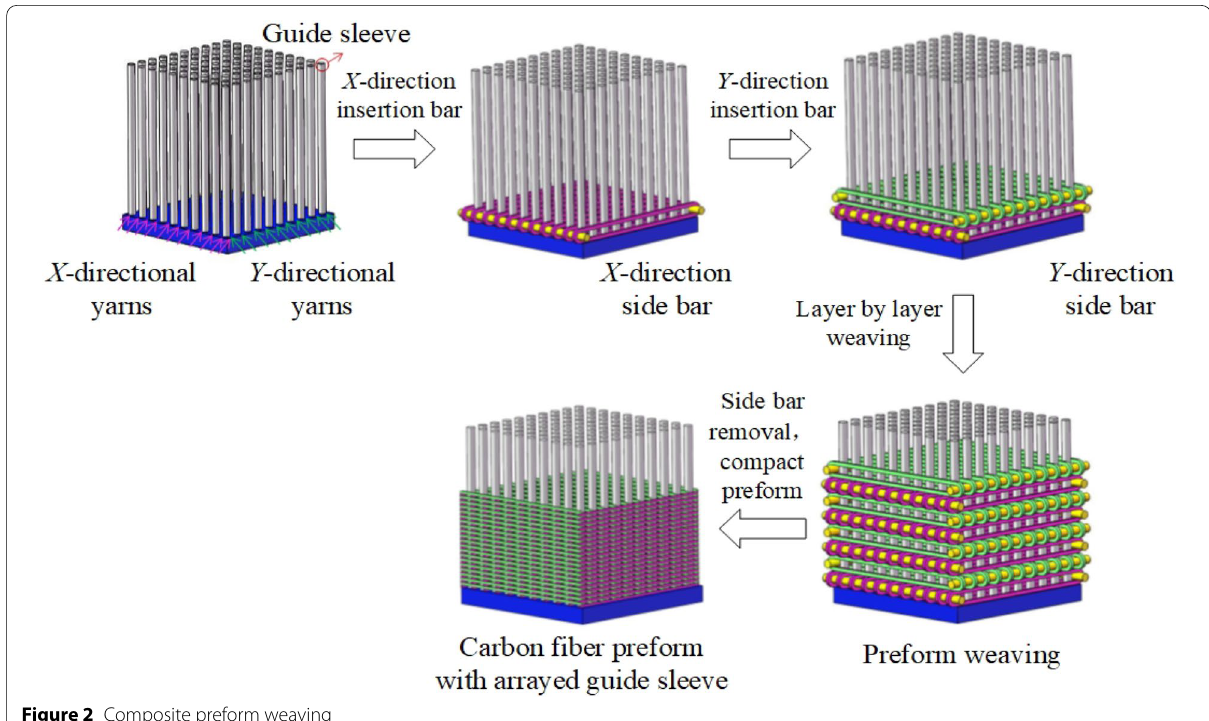
Figure 2 Composite preform weaving